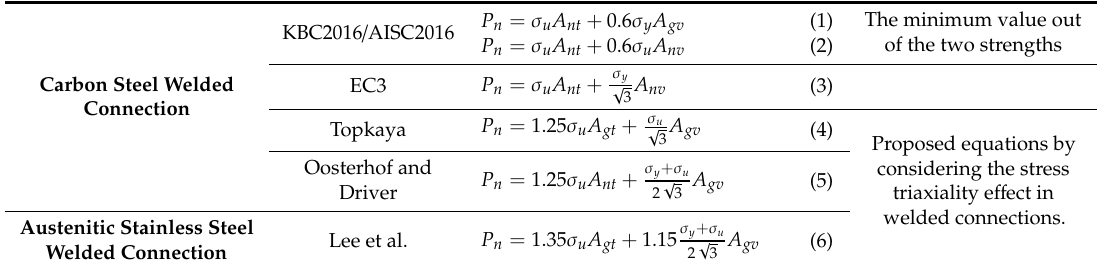
Table 4. Current design standards and equations by other